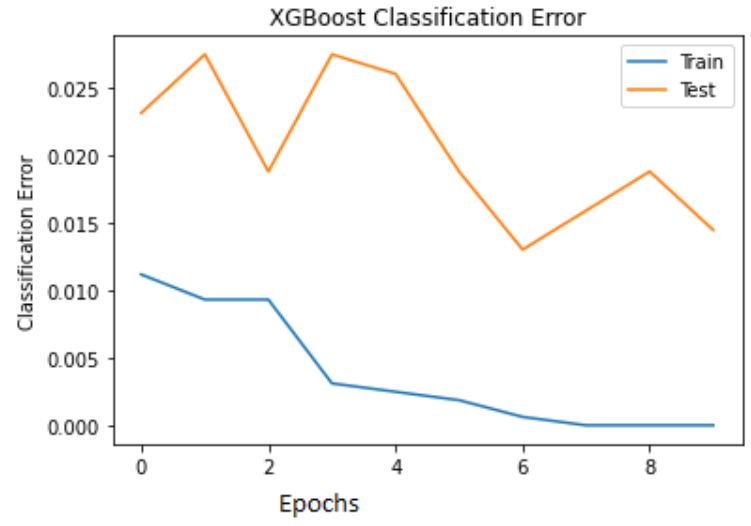
Figure 9. XGBoost classification error curve.